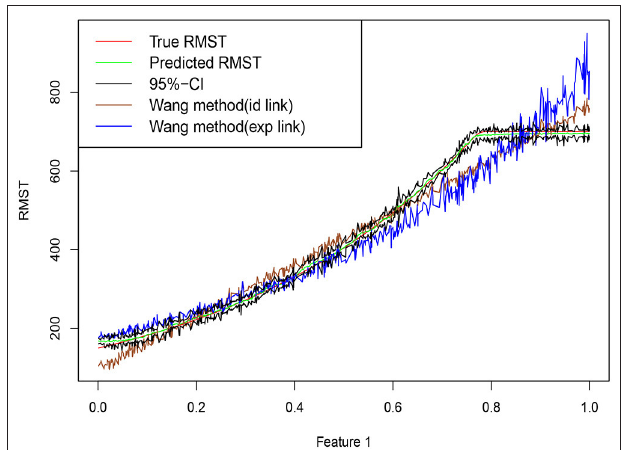
FIGURE 1 | Training data are simulated from Equation (2), with n = 600 training points, dimension p = 20 and errors ǫ ∼ N (0,10 2 ). Random forests are trained based using R package grf. Truth is shown as red curve, with green curve corresponding to the random forest predictions, and upper and lower bounds of the point-wise confidence intervals connected in the black lines. Brown curve and blue curve are based on the approaches of Wang and Schaubel (2018) with Identity and Exp link